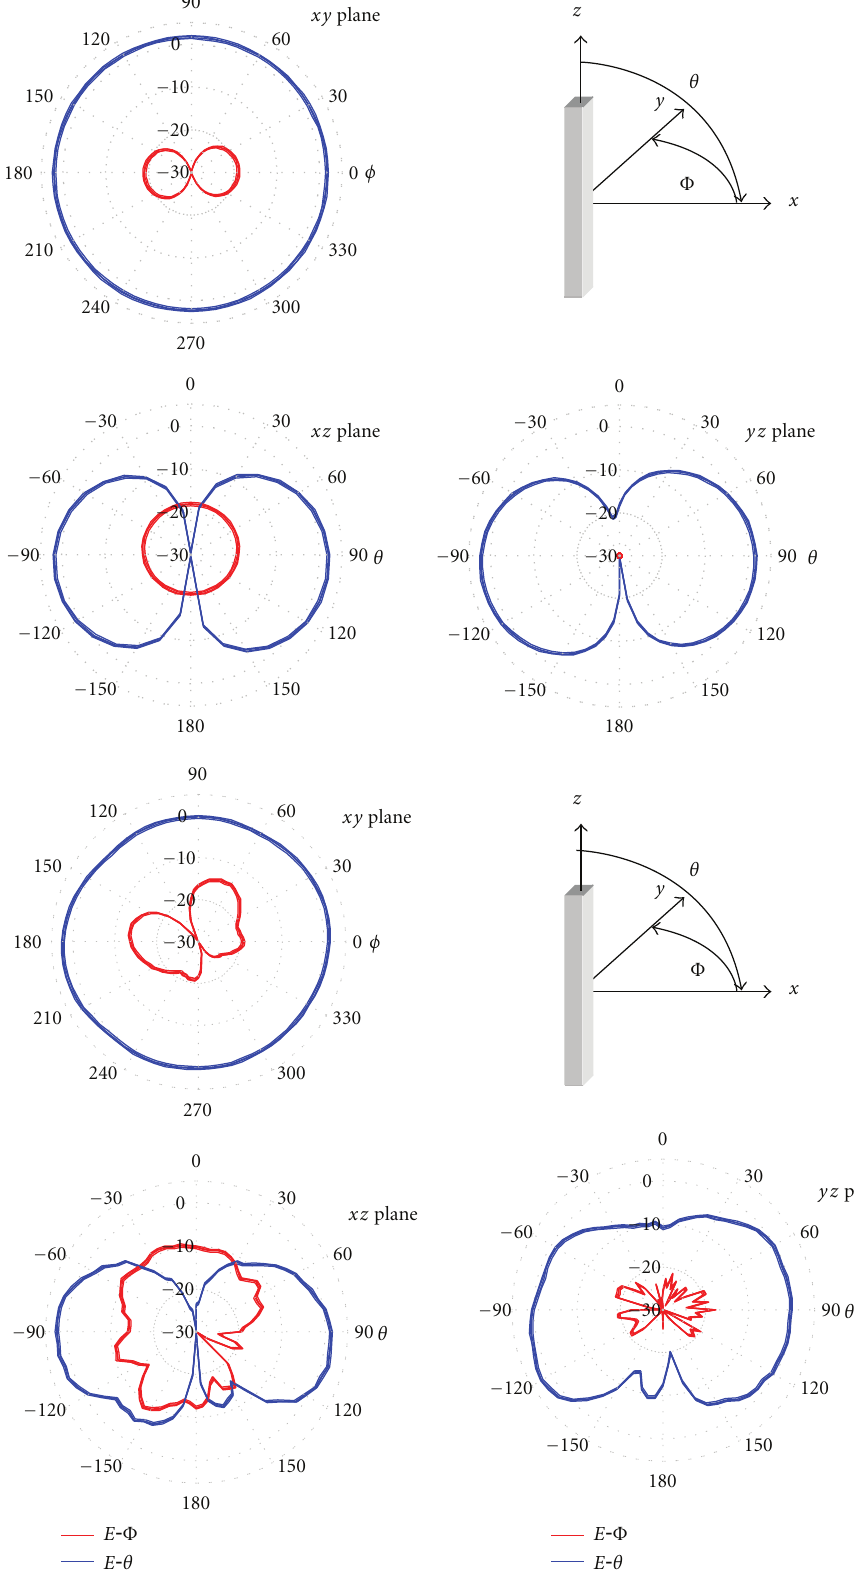
Figure 4: (a) Calculated radiation patterns of the high-band antenna at 2.4 GHz. (b) Measured radiation patterns of the high-band antenna at 2.4